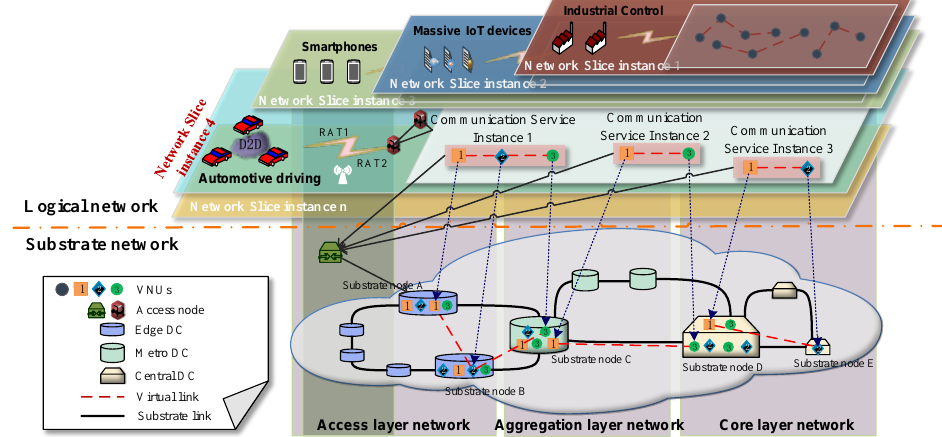
Figure 1. Example of the VNFs resource allocation for backhaul transport network